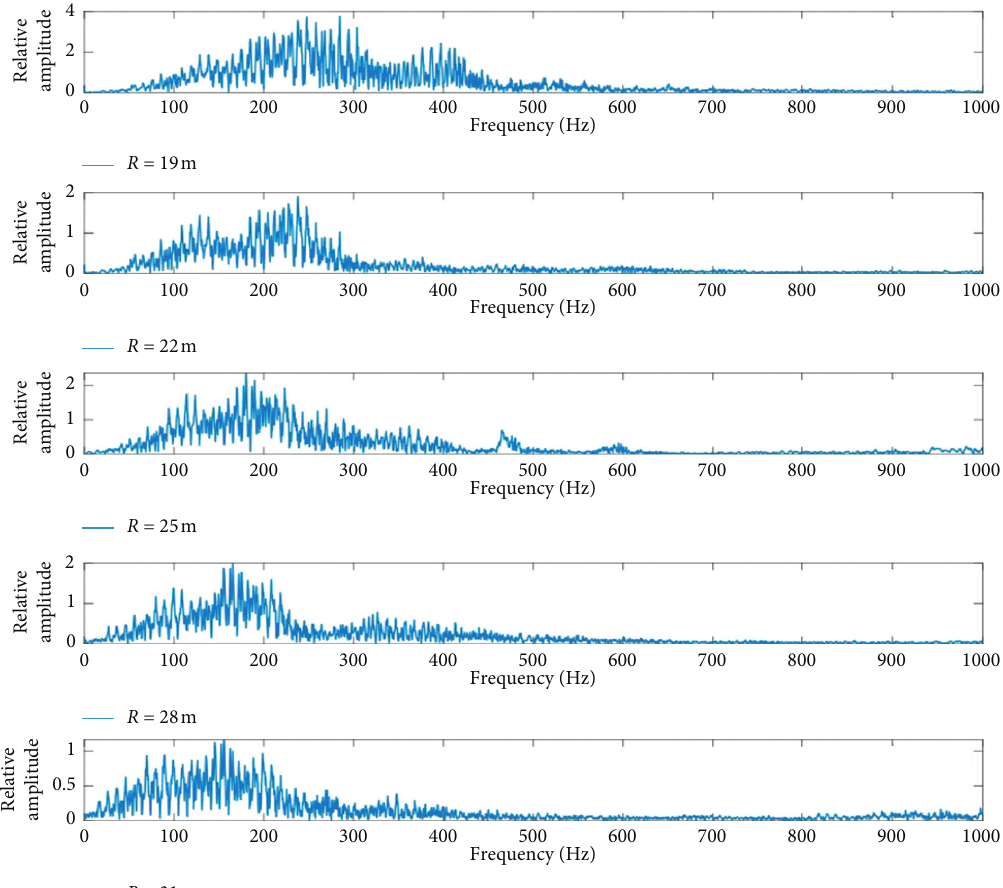
Figure 10: Vibration frequency distribution map at different blasting center